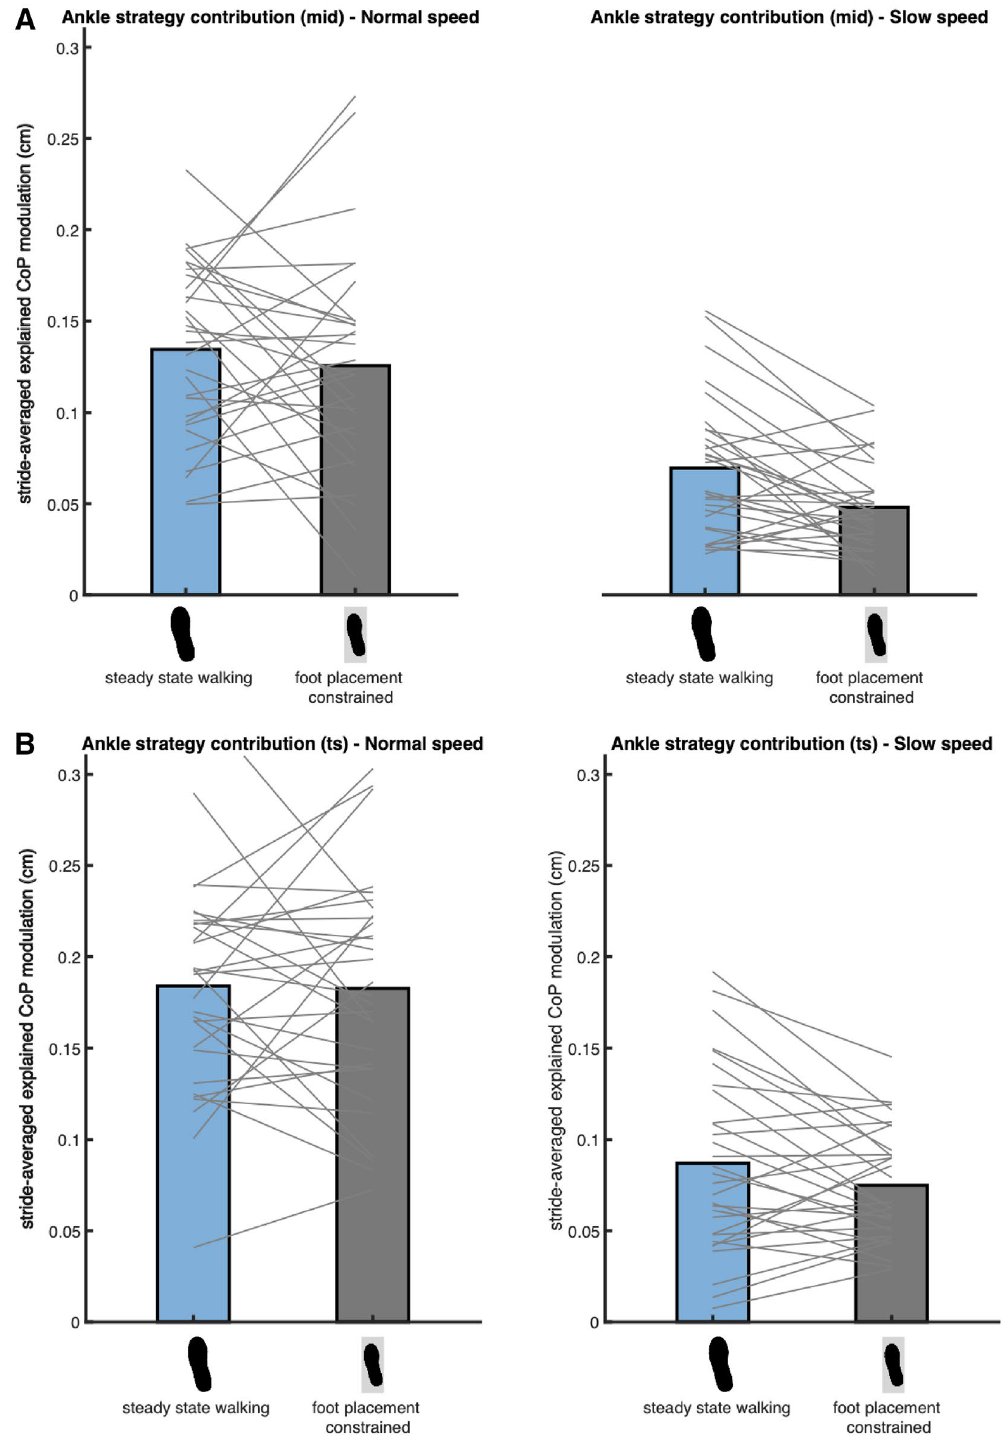
Figure 7. Mean absolute explained variance of the ankle strategy model (2). For normal (left) and slow (right) walking speeds panels A and B depict respectively the absolute explained variances for the foot placement error at mid- and terminal swing. Blue and grey bars represent the steady-state walking and foot placement constrained conditions respectively. In this figure the absolute explained variance is expressed as the square root of the stride averaged explained variance, as a reflection of the magnitude of the average explained CoP shift in centimeters. The grey lines connect individual data points. As the best model did not include the factor Condition, no Bayes factors have been presented. This figure was created using Matlab 2021a (https:// www. mathw orks. com/ produ cts/ matlab. html) and Adobe Illustrator CC 2018 (https:// www. adobe. com/ nl/ produ cts/ illus trator.